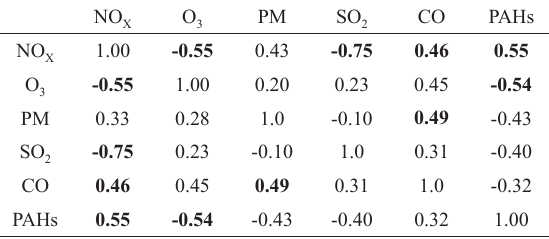
Correlations of the atmospheric pollutants in the